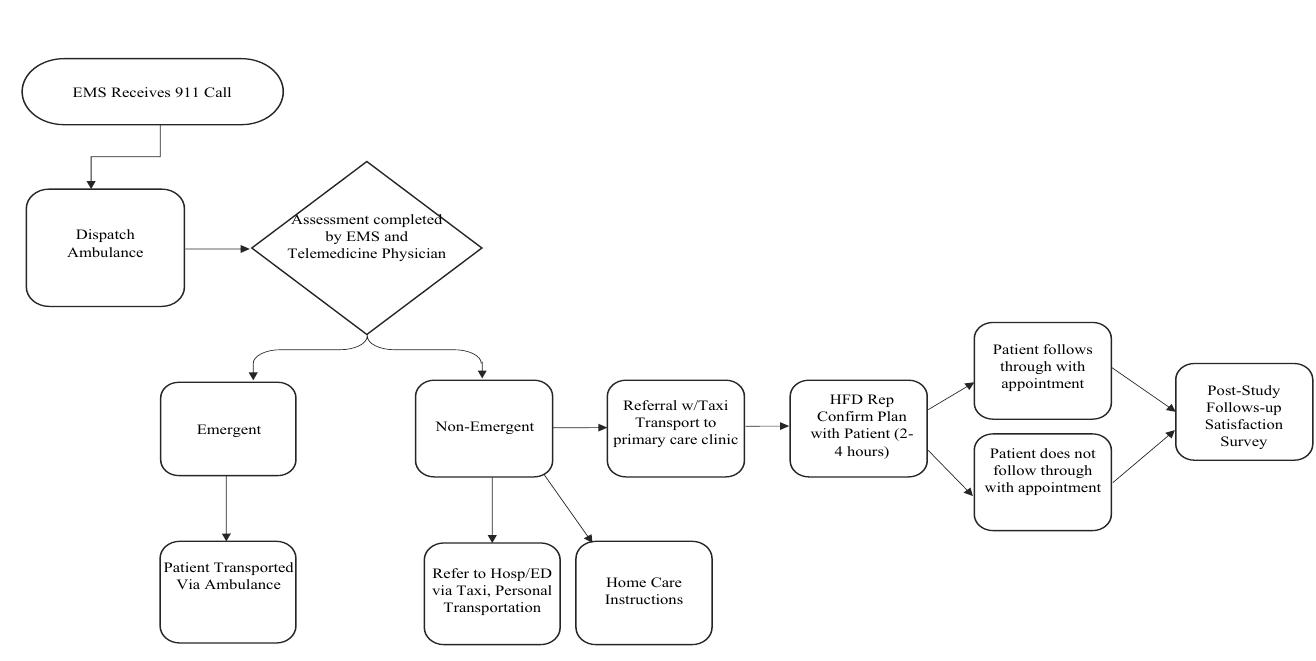
Figure. Study of intervention protocol flow